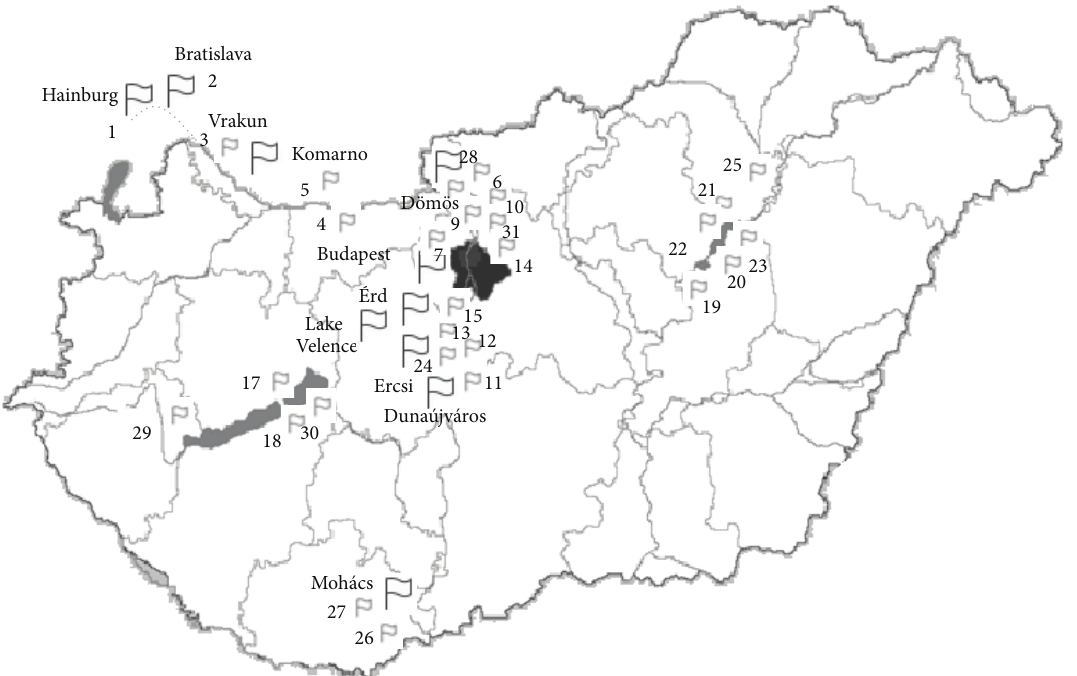
Figure 4: Surface water sampling sites along the Danube and throughout the country in